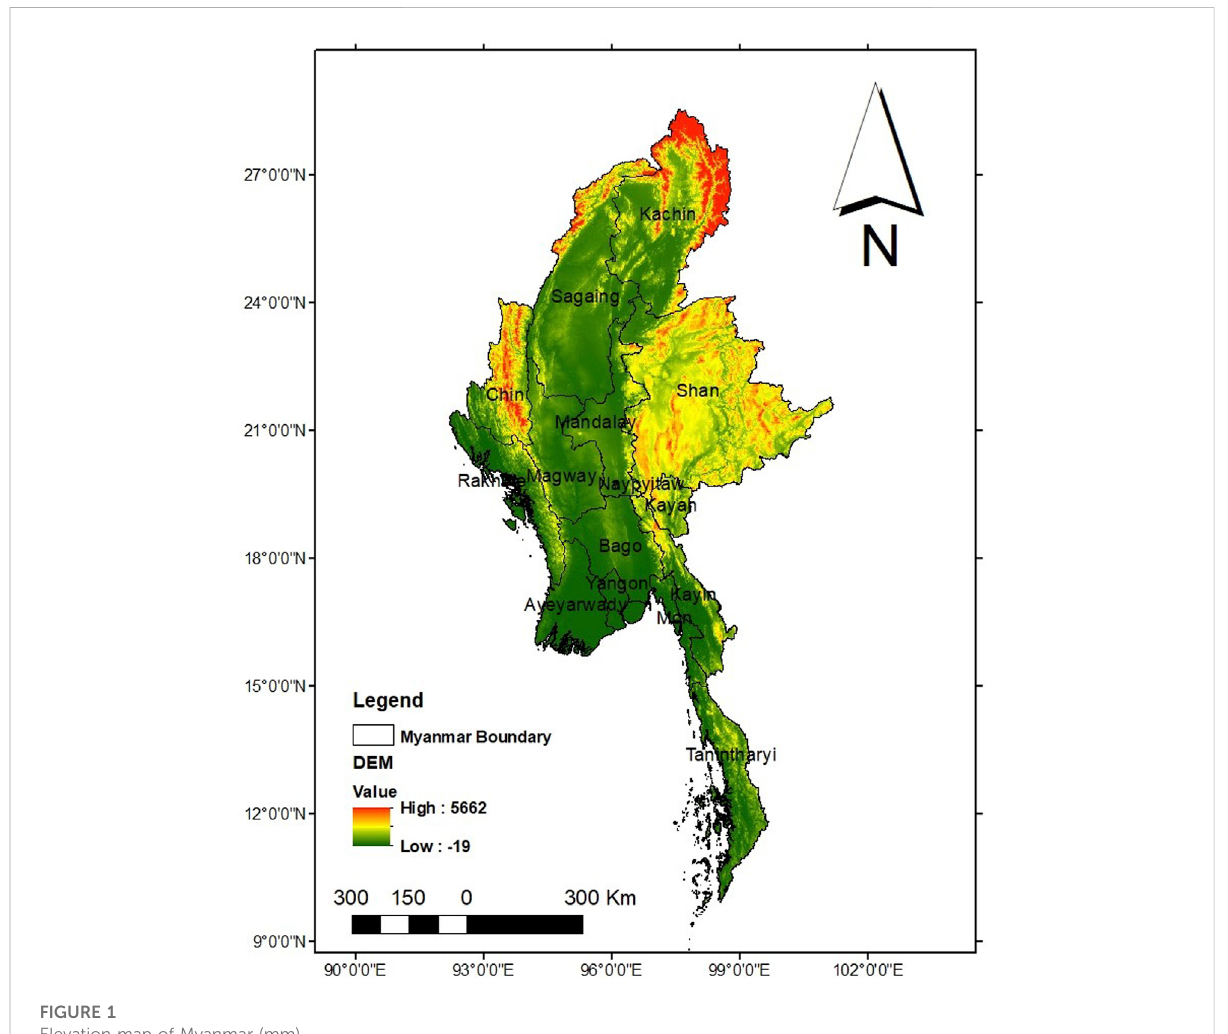
FIGURE 1 Elevation map of Myanmar